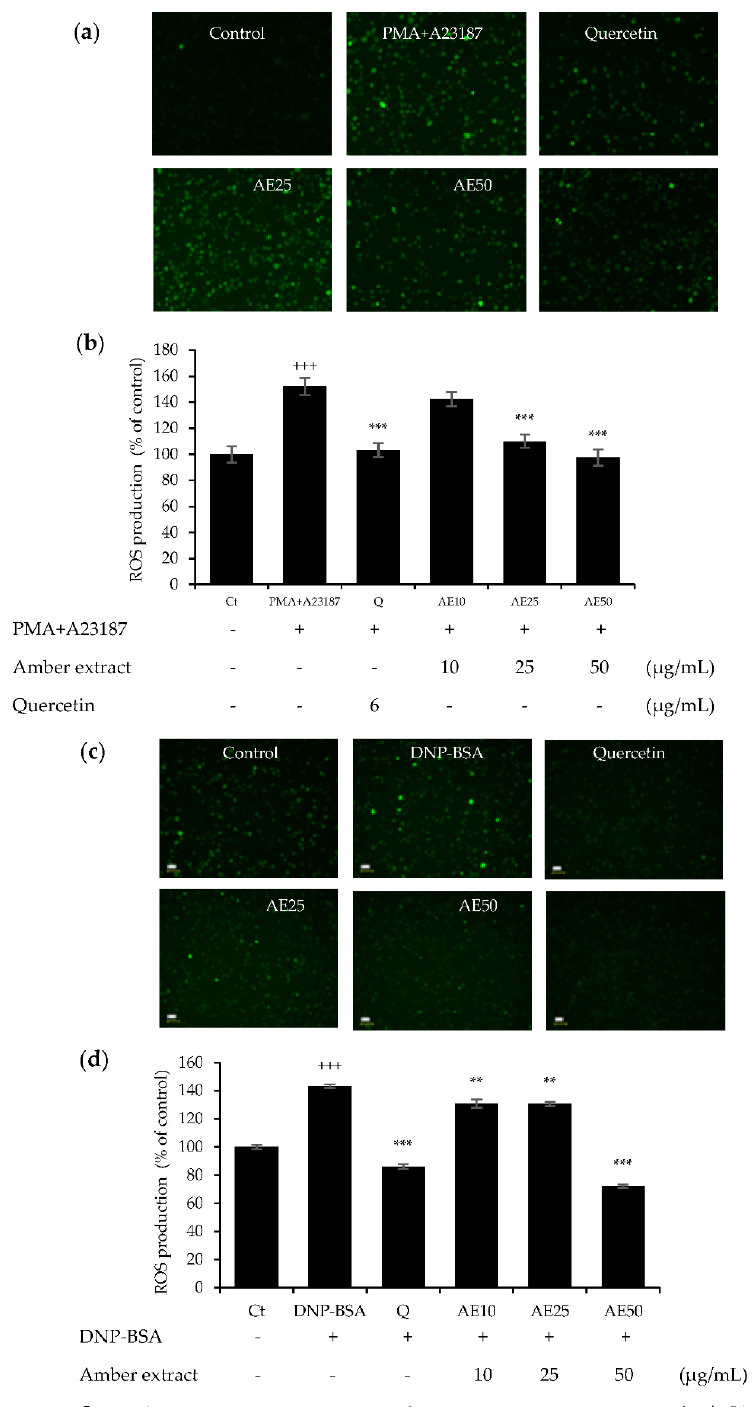
Figure 4. Effect of amber extract on ROS generation: ( a ) ROS generation staining in PMA+A23187- stimulated RBL-2H3 cells. ( b ) ROS production in PMA+A23187-stimulated RBL-2H3 cells. ( c ) ROS generation staining in DNP-BSA-stimulated RBL-2H3 cells. ( d ) ROS production in DNP-BSA-stim- ulated RBL-2H3 cells. Cells were stained with 2 ′ ,7 ′ dichlorodihydrofluorescein diacetate (DCFDA) for 20 min. The cells were photographed at 20× magnification using a fluorescent microscope. The presence of ROS is indicated in green. ROS production was measured on a fluorescence plate reader